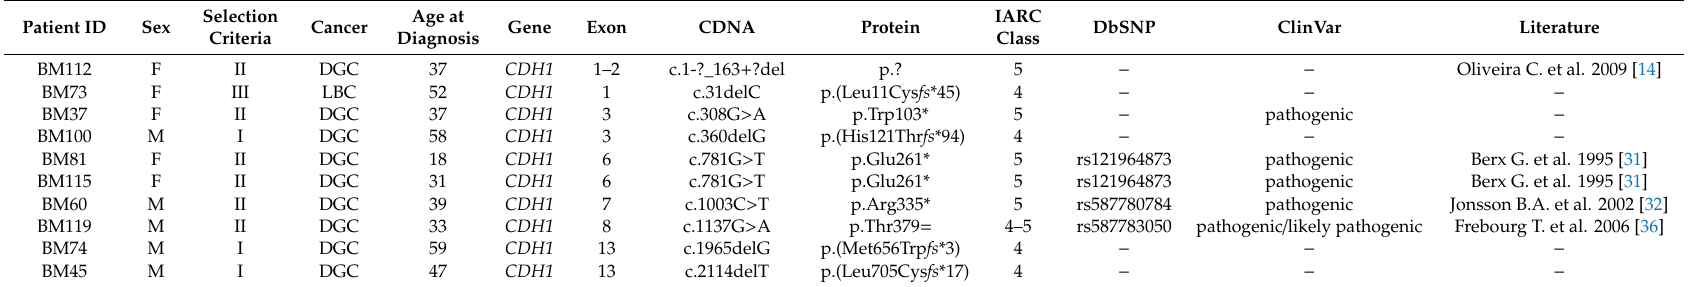
Table 2. Carriers of CDH1 deleterious variants.